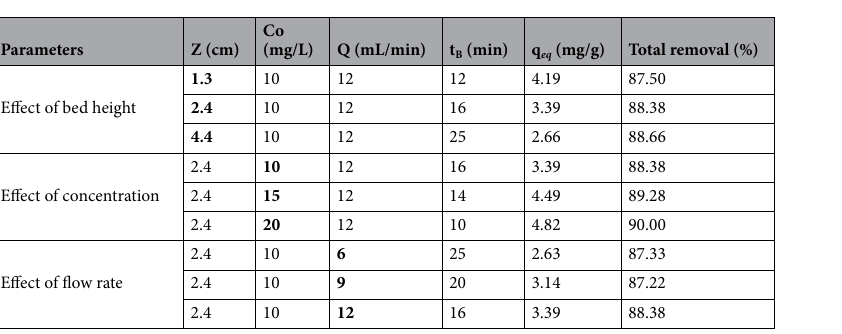
Table 4. Description of column parameters of cadmium ions on activated hydrochar. Significant values are in bold.